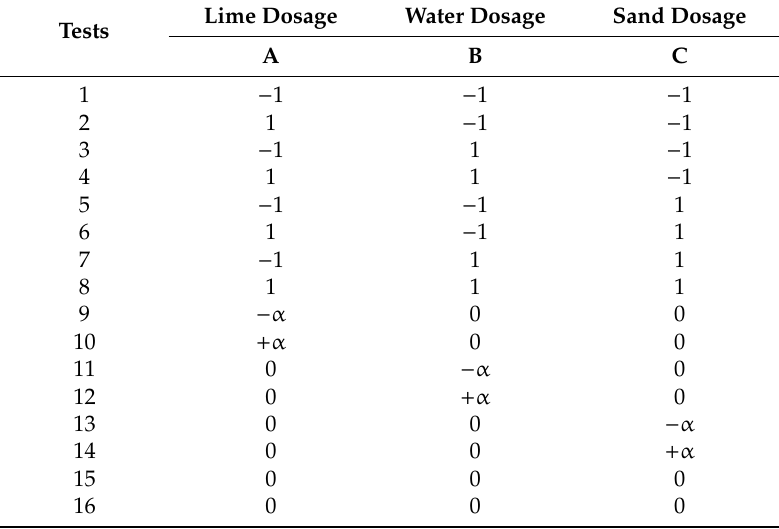
Table 2. Matrix of the tests of the composite centered factorial plan adopted for the treatment of bottom ash (BA).